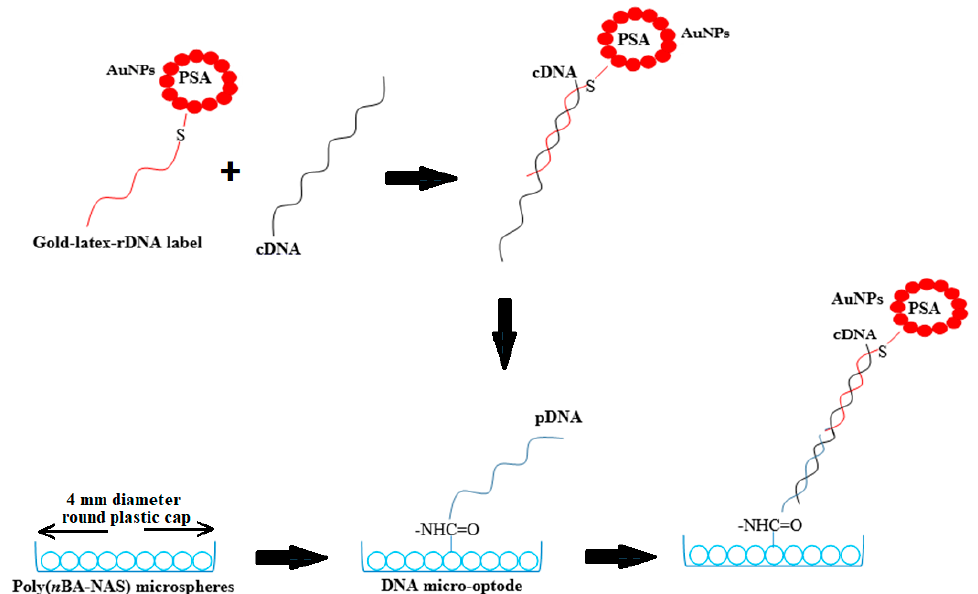
Figure 1. Schematic diagram showing the one-step sandwich hybridization recognition procedure, which involves a DNA capture probe (pDNA) immobilized on the acrylic microspheres, and target (cDNA) and reporter (rDNA) probes labeled with gold nanoparticle–poly(styrene- co -acrylic acid) latex (AuNP–PSA) spheres.